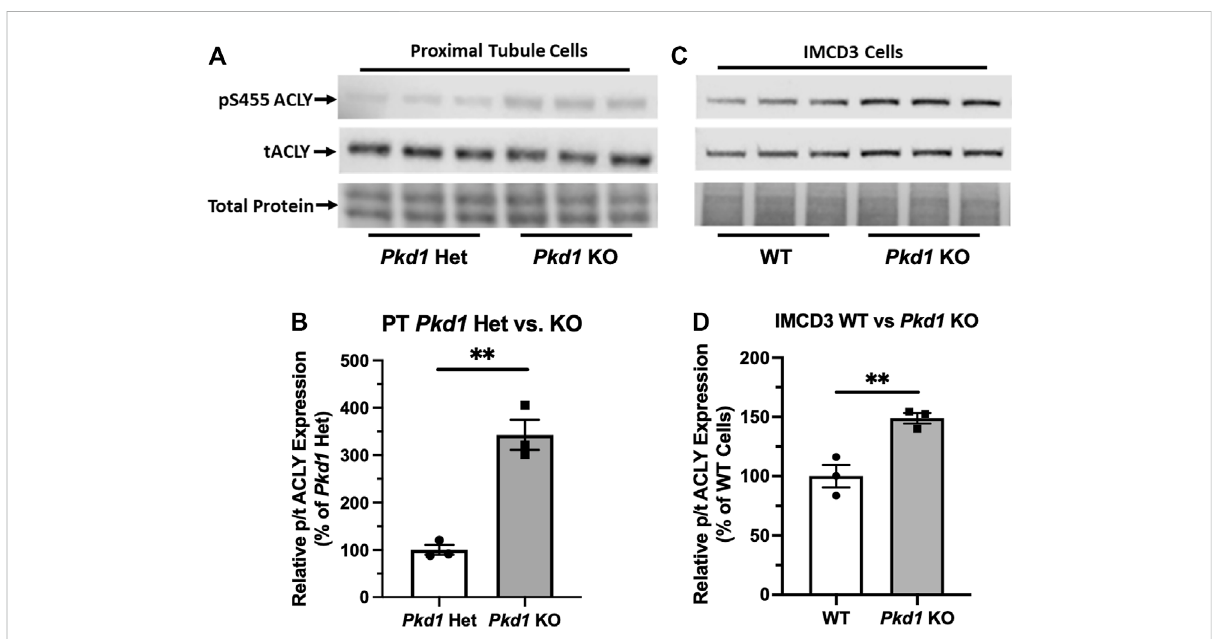
FIGURE 3 ACLYactivityisincreasedinPkd1 − / − kidneyepithelialcellsascomparedtocontrols. (A) Immunoblottingofproximaltubule(PT)-derivedmouse epithelial cells probed for total ACLY expression (tACLY, upper) and activated ACLY, as detected using a phospho-speci fi c antibody directed against theAktphosphorylationsiteSer455(pS455ACLY,middle),inPN24cellswith Pkd1 expressionknockedoutatbothallelesascomparedwithPH2cells heterozygous for Pkd1 deletion. Lower, total protein staining as loading control. (B) Densitometric quantitation of the pS455 ACLY/tACLY ratio shows asigni fi cant ~250%increasein ACLYactivation inthe Pkd1 -null cells as compared to Pkd1 -hetcontrols (** p < 0.01; unpaired t -test; n =3). (C) Immunoblotting of inner medullary collecting duct (IMCD)-derived mouse epithelial cells for expression of tACLY (middle) and pS455 ACLY